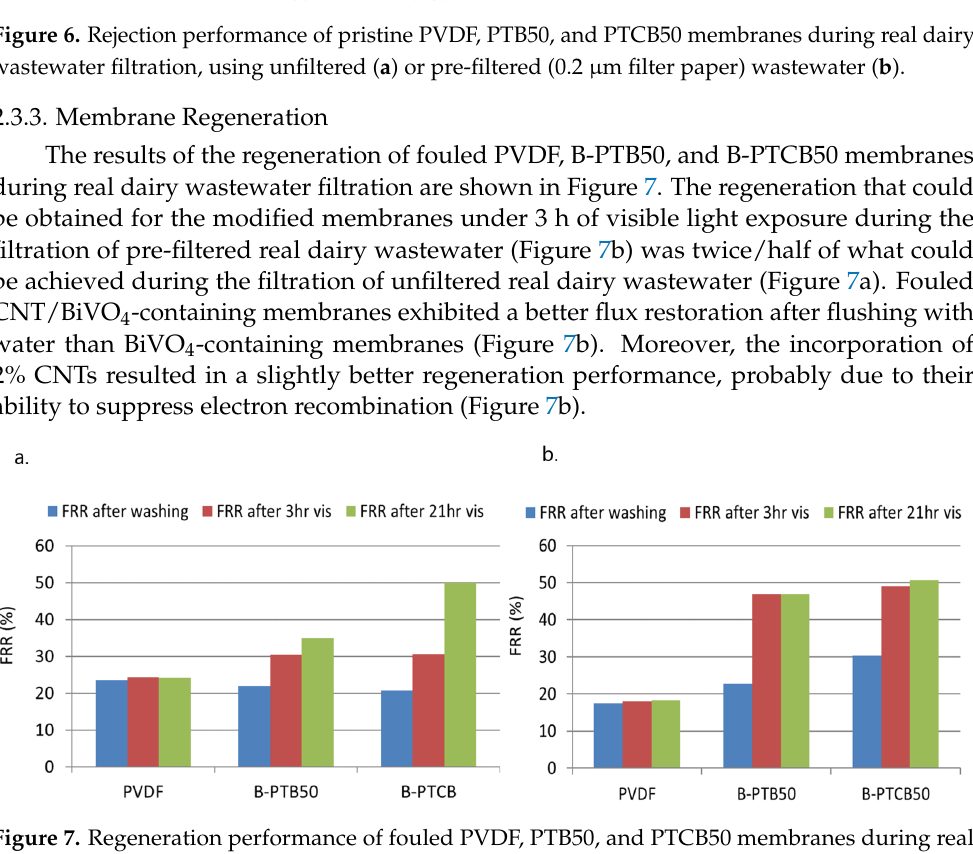
Figure 7. Regeneration performance of fouled PVDF, PTB50, and PTCB50 membranes during real dairy wastewater filtration, using unfiltered ( a ) or pre-filtered (0.2 µm filter paper) wastewater ( b ).